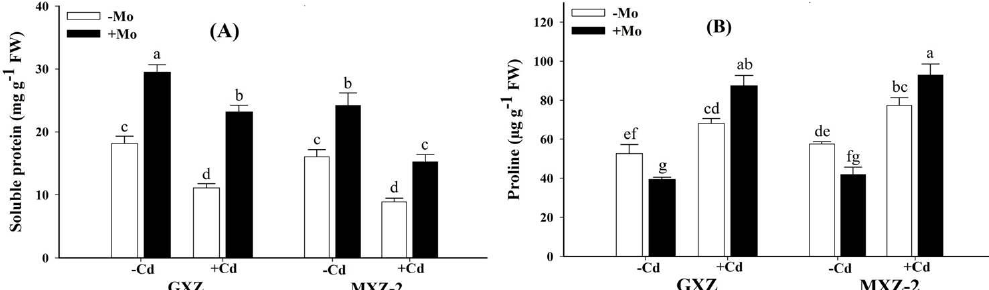
Figure 2. Influence of molybdenum (Mo) and cadmium (Cd) on ( A ) soluble protein, and ( B )